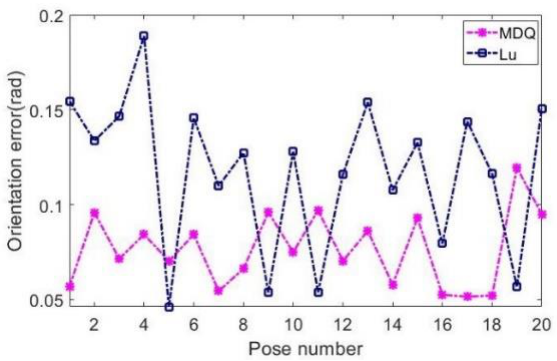
Figure 10. Comparison of the RMS errors in rotation of the calibration results.